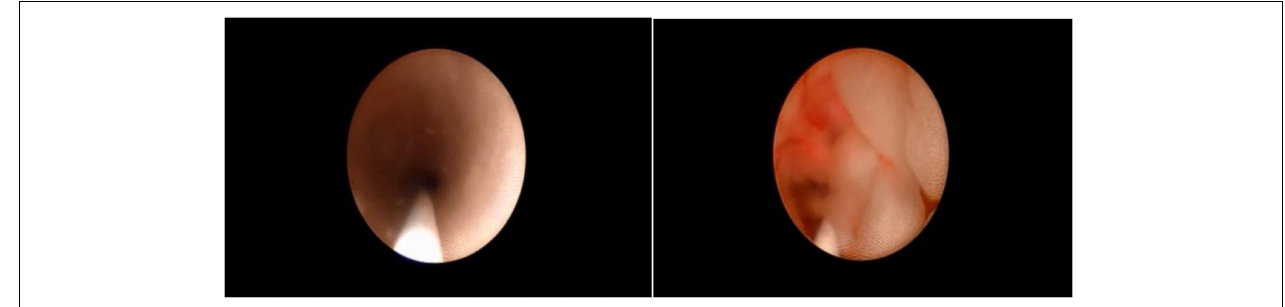
FIGURE 1 | Ureterorenoscopy procedure. Edema of the ureteral